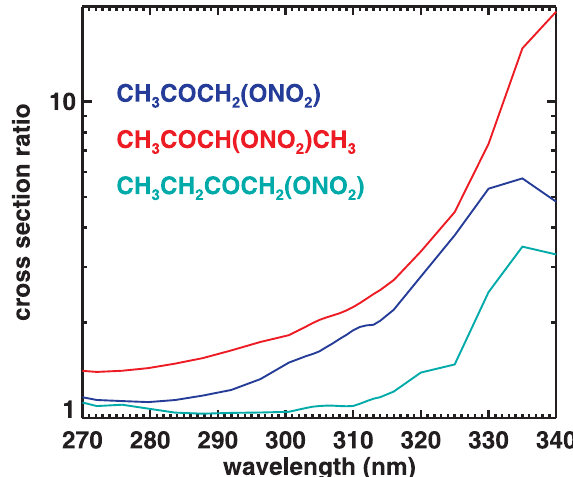
Fig. 1. Cross section enhancement ( r nk ) of several nitrooxy ke- tones, i.e. ratio of their cross section ( S nk ) to the sum of the cross sections of structurally similar monofunctional compounds S n + S k